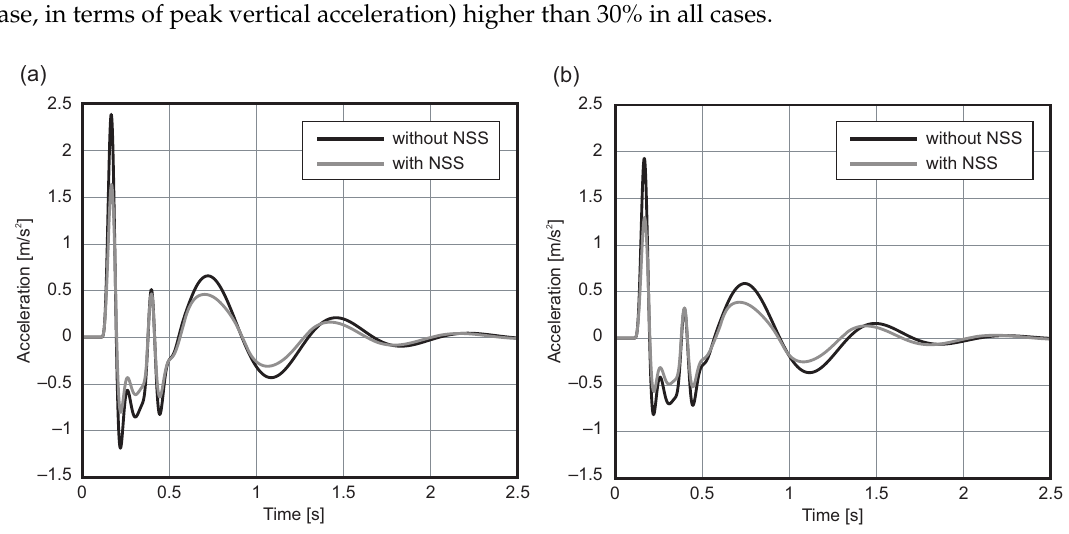
Figure 10. Acceleration values when traversing a speed bump at 40 km/h with a mass of ( a ) 60 kg and ( b ) 90 kg.